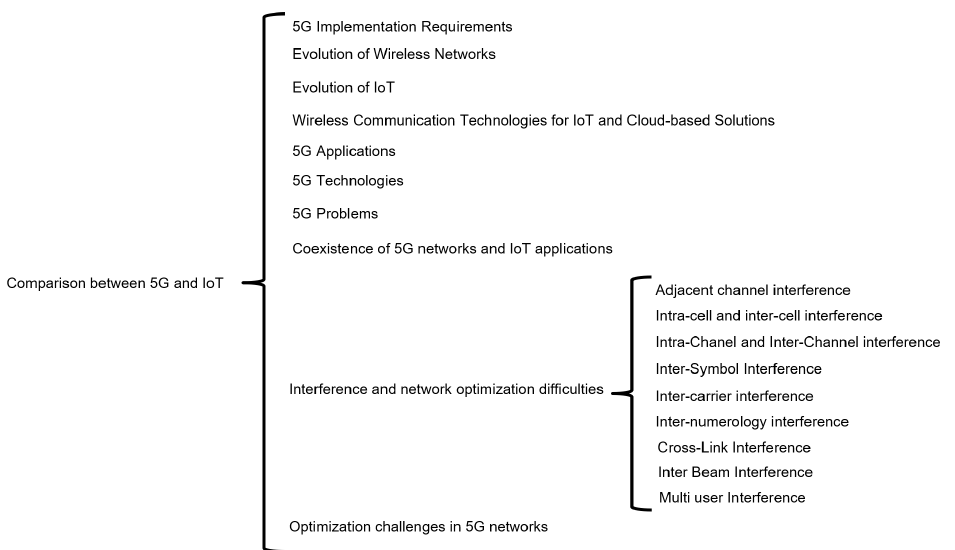
Figure 1. Summary of conceptual schemes that addresses the present